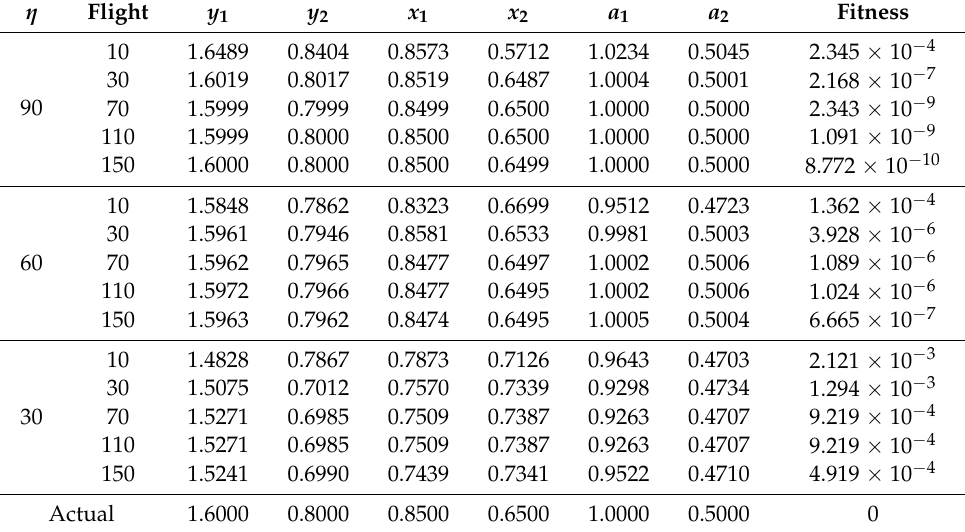
Table 1. Parameter estimates with the level of estimation accuracy for ε = 0.1.